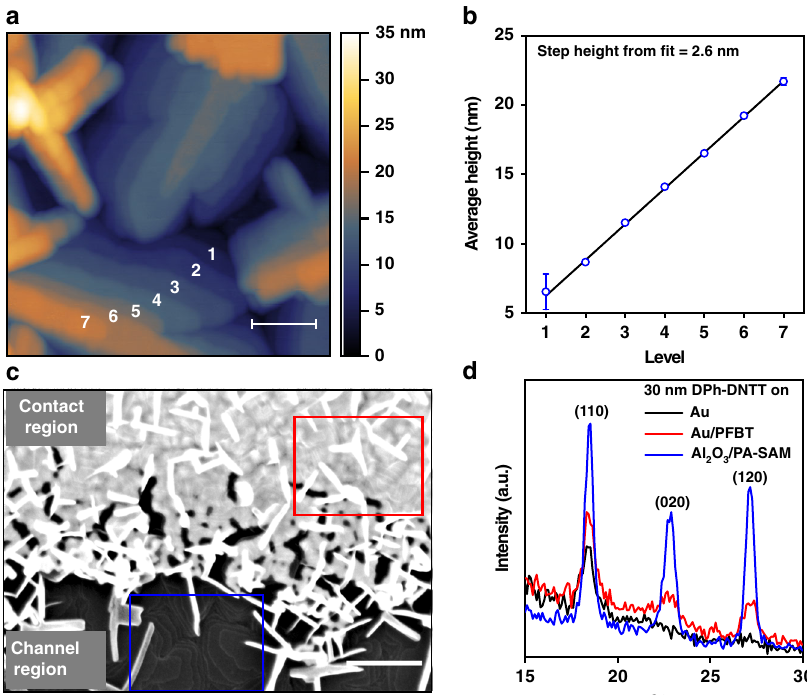
Fig. 2 Morphological characterization of vacuum-deposited DPh-DNTT fi lms. a AFM topography image of a DPh-DNTT layer formed on the Al 2 O 3 /SAM gate dielectric. Individual terrace levels are indicated with numbers 1 – 7. The scale bar corresponds to 100 nm. b Analysis of the height differences between the terraces. The step height of 2.6 nm corresponds closely to the length of a DPh-DNTT molecule, indicating that the molecules in each layer are oriented approximately upright with respect to the gate-dielectric surface. The data points and the error bars were obtained by local averaging of the terrace height over a large number of locations on each terrace in the AFM height image. c SEM image of the contact edge of a DPh-DNTT bottom-contact TFT with PFBT-treated gold contacts. The terrace morphology of the DPh-DNTT fi lm is distinguishable on the contact surface near the contact edge (red box) and in the channel region (blue box). The scale bar corresponds to 200 nm. d Grazing incidence X-ray diffraction measurements on 30-nm-thick DPh-DNTT fi lms on surfaces consisting of Au (black), PFBT-treated Au (red), and atomic-layer-deposited Al 2 O 3 passivated with n- tetradecylphosphonic acid (PA-SAM, blue). The (110), (020), and (120) peaks are clearly distinguished in both of the latter two cases, signifying in-plane π – π stacking 48 , while on bare Au only the (110) peak is present